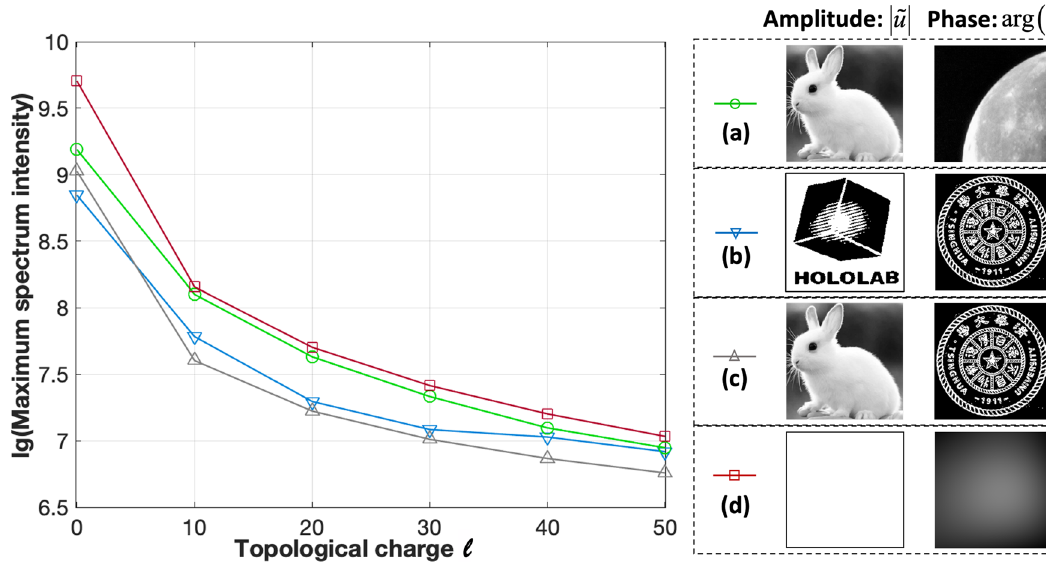
Figure 4. Logarithmic profile of the maximum intensity value of the modulated spectrum with topological charge l from 0 to 50. (a) Amplitude and phase; (b) binary amplitude and binary phase; (c) amplitude and binary phase; (d) wavefront. arg(): phase operator.